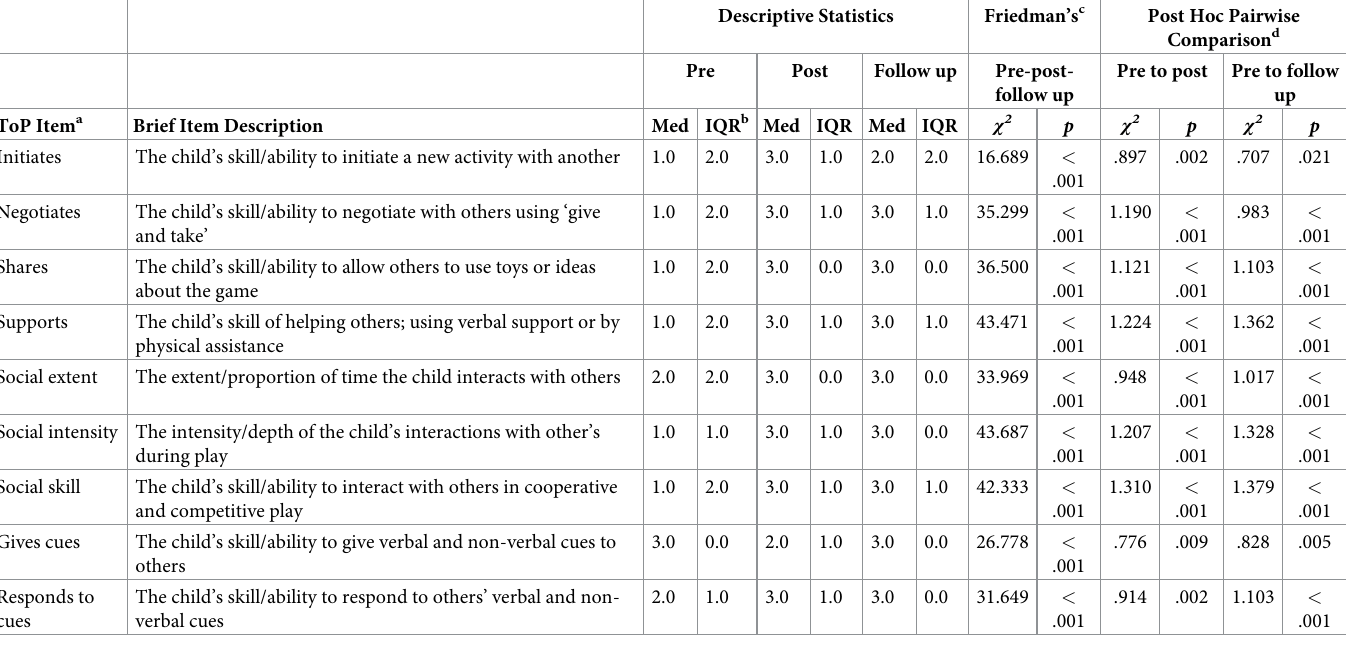
Table 2. Playmates’ changes in ToP social skill item scores over